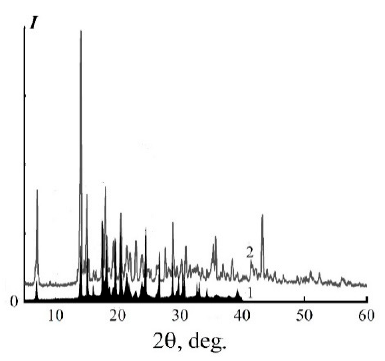
Figure 4. X-ray diffraction patterns of NMMO (1) and systems of 80% NMMO–20% IBA (2).